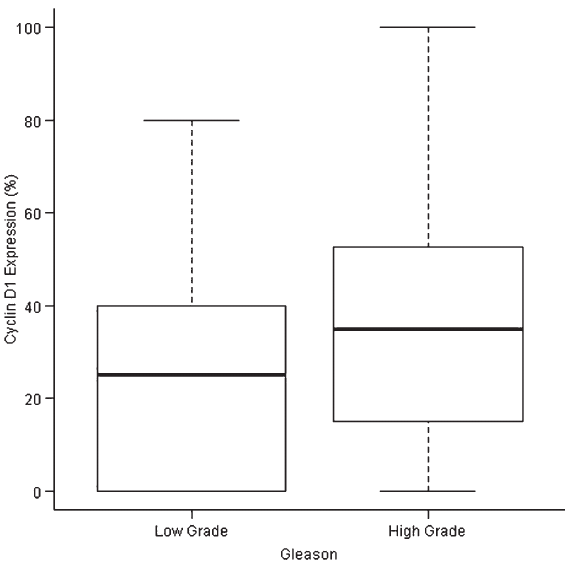
Figure 3. Distribution of Gleason scores according to cyclin D1 expression.